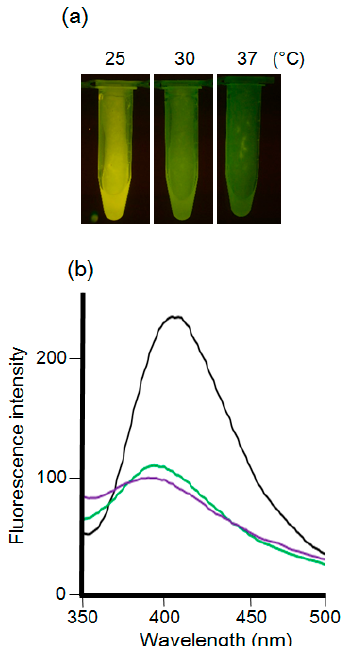
Figure 5. ( a ) F. oxysporum after the treatment of 5 mM CdCl 2 and Na 2 SeO 3 (pH 7.5) at various temperatures observed under the UV light (wavelength: 365 nm). From the left side, each tube indicated 25, 30 and 37 °C, respectively; ( b ) The fluorescence spectra (excitation at 310 nm) of extracts from the mycelial cells in each condition using ultrasonication. Black line: 25 °C. Green line: 30 °C. Purple line: 37 °C.